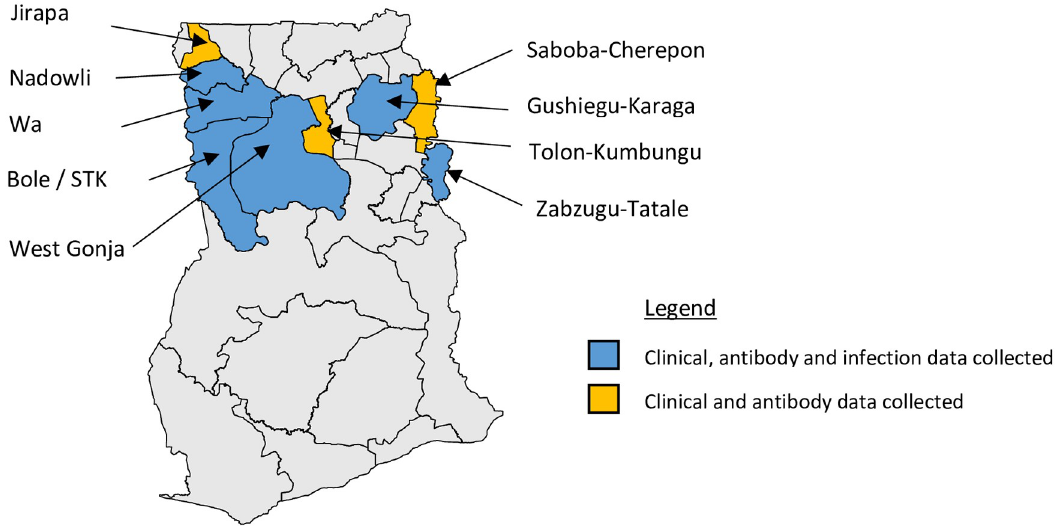
Fig 1. Map of the evaluation units, indicating data types generated in each unit. Adapted from an open source map retrieved from www.mapmaker.com.